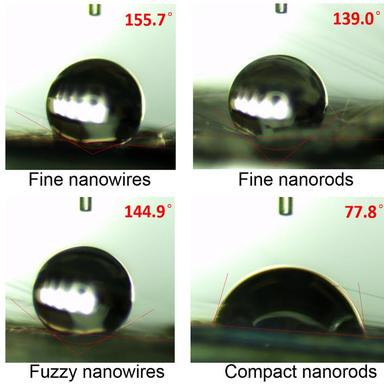
Contact angles of four types of synthesized hybrid structural fiber fabrics.